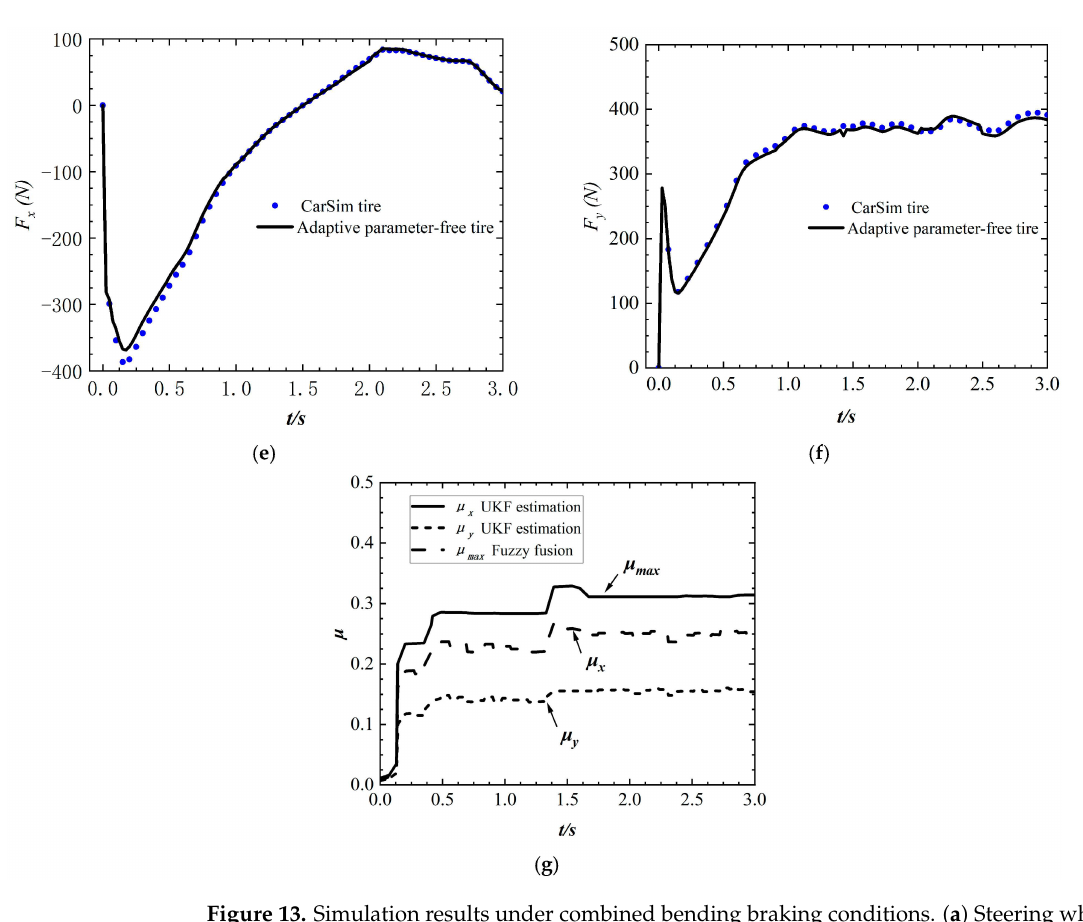
Figure 13. Simulation results under combined bending braking conditions. ( a ) Steering wheel corner- ing. ( b ) Longitudinal slip rate. ( c ) Longitudinal acceleration. ( d ) Lateral acceleration. ( e ) Longitudinal force contrast curve. ( f ) Lateral force contrast curve. ( g ) Estimated pavement adhesion coefficient.